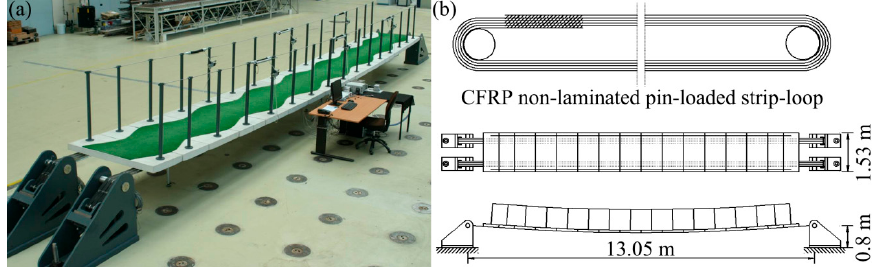
Figure 25. TU Berlin CFRP Stress-Ribbon Footbridge ( a ) photo (photo credit: Achim Bleicher); ( b ) sketch.